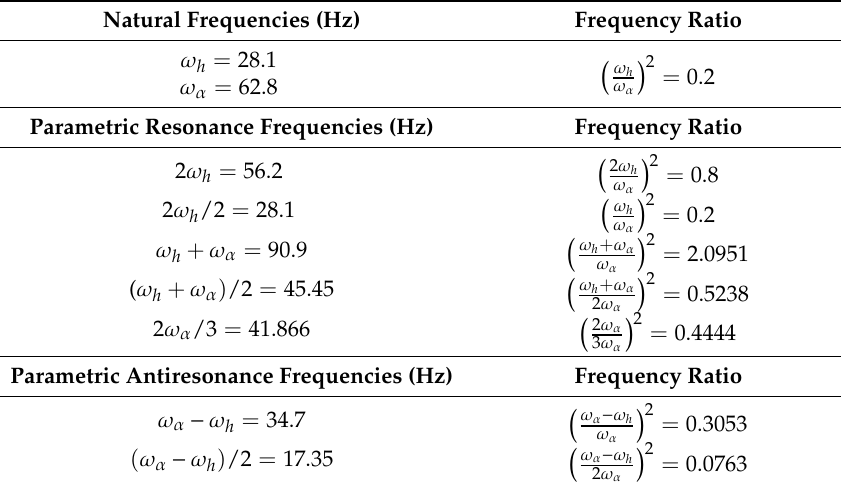
Table 1. Natural and parametric resonance frequencies.